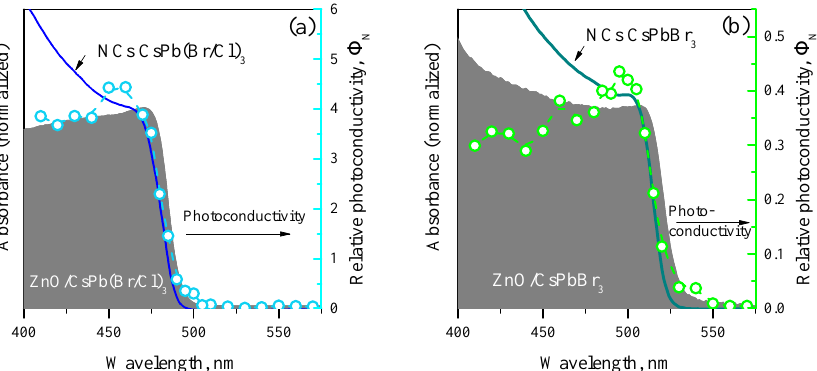
Figure 9. Spectral dependence of photoconductivity of ZnO/CsPb(Cl/Br) 3 ( a ) and ZnO/CsPbBr 3 nanocomposites ( b ). The areas with a solid fill relate to the absorption spectra of the corresponding nanocomposites, the solid lines relate to the absorption spectra of the corresponding PNCs hexane dispersions, the dots with a dashed line relate to the photoconductivity spectra of the nanocomposites.